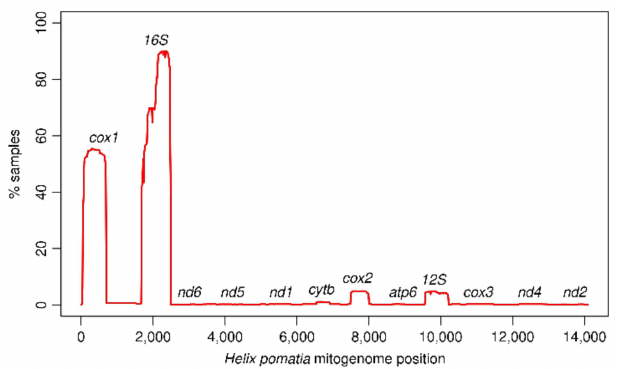
Figure 1. Representation of the mitogenome among the available sequences of mitochondrial markers of Helicini, plotted along the mitogenome of Helix pomatia . All sequences were aligned with the mitogenome and positions with gaps in the mitogenome were removed. For each position of the alignment, we calculated the percentage of all analysed individuals (out of 2566 included in this study) in which that position was covered. The percentages were averaged and plotted in 10 bp